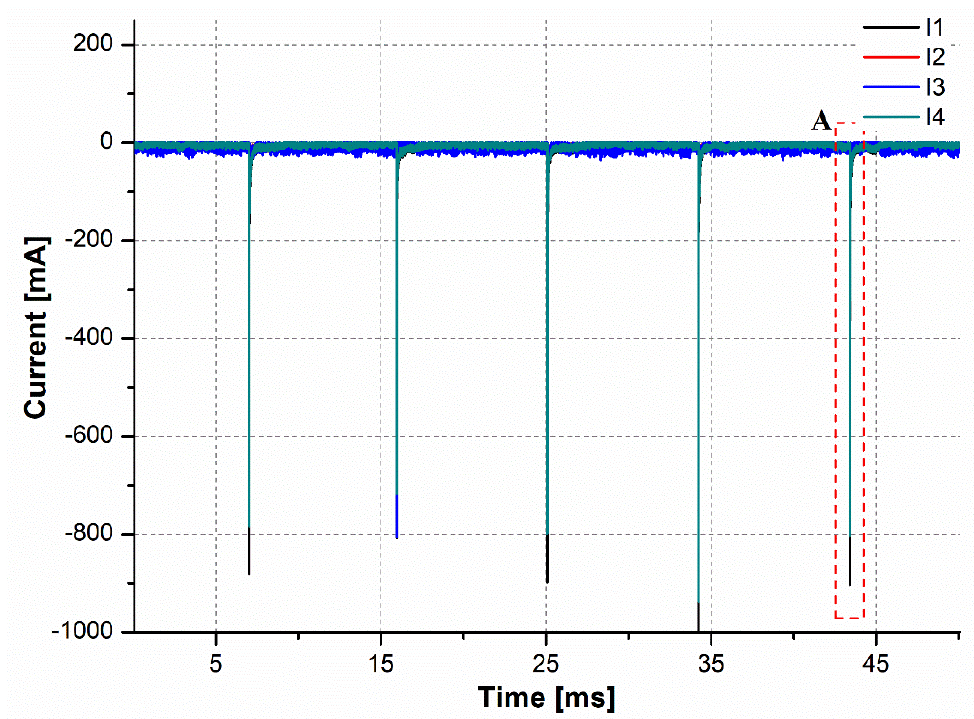
Figure 13. Current waveforms of the four RCG reactors working in parallel—the current for the four reactors (I1–I4).